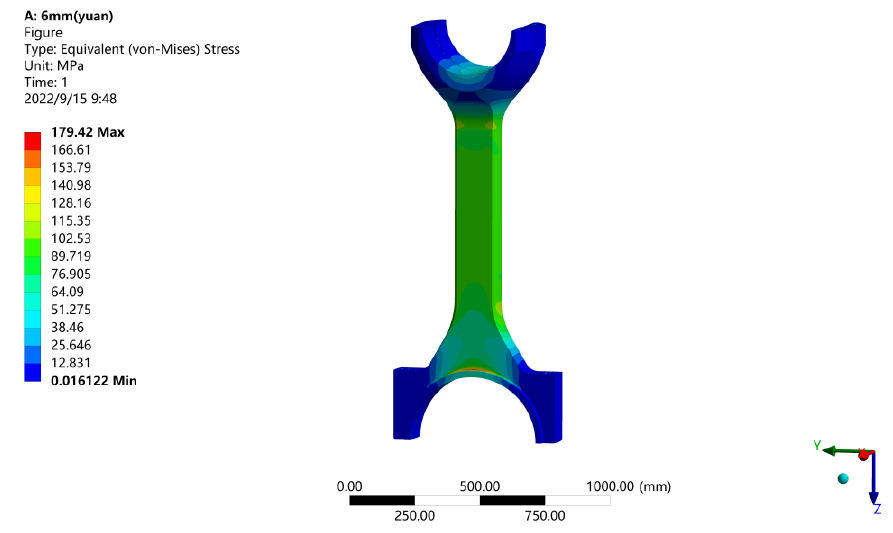
Figure 12. Stress diagram of connecting rod body.